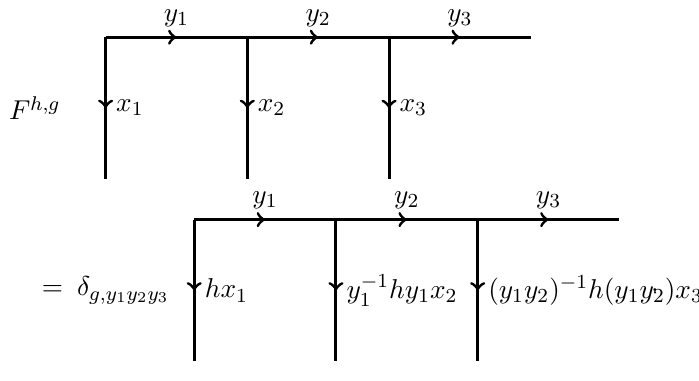
Figure 10 . Ribbon